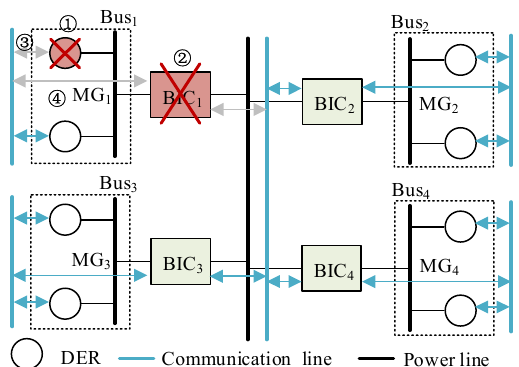
Figure 8. Description of converter outage and communication failure.